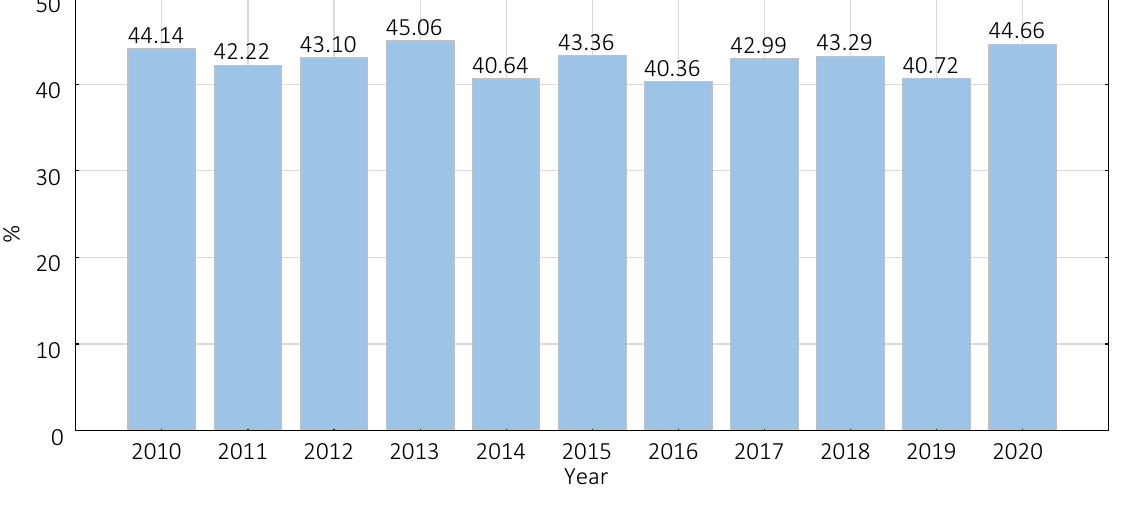
Figure 3. The share of constructions and buildings in gross fixed capital formation